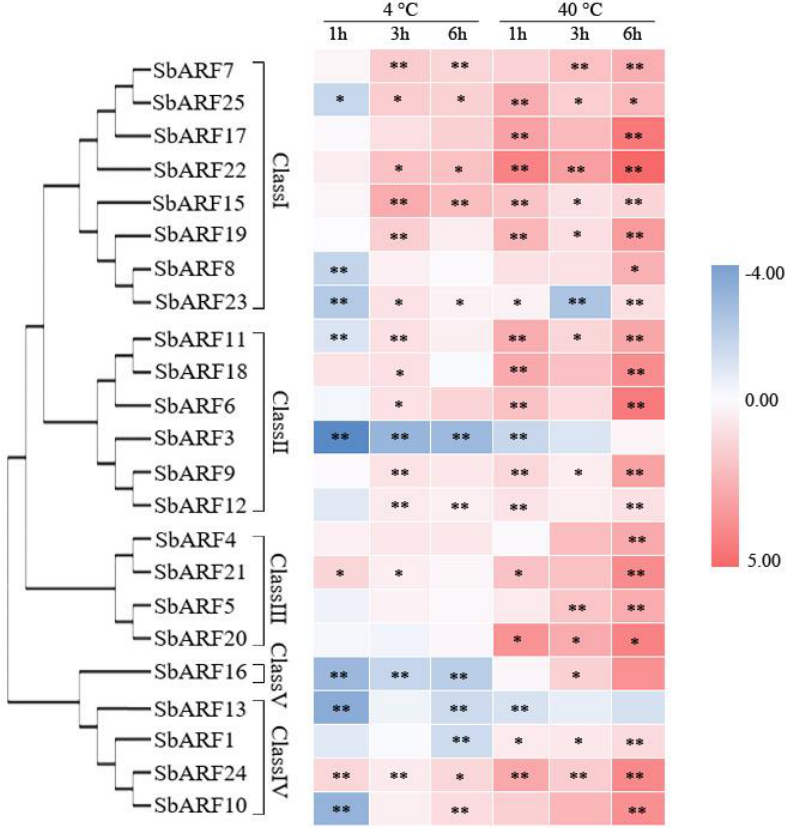
Figure 5. Expression profiles of SbARF genes in sorghum seedling under cold and heat stress. The heatmap was generated based on the relative expression values of 25 SbARFs genes obtained by qRT-PCR. The expression levels of ARF genes under non-stressed conditions were defined as 1. The red and blue color scale represents log2-transformed values and indicates relatively high or low expression, respectively. Data from three biological replicates are displayed with standard deviation. Asterisks on the top of bars indicate significant differences as determined by Student ’ s t -test (*: p < 0.05; **: p < 0.01).